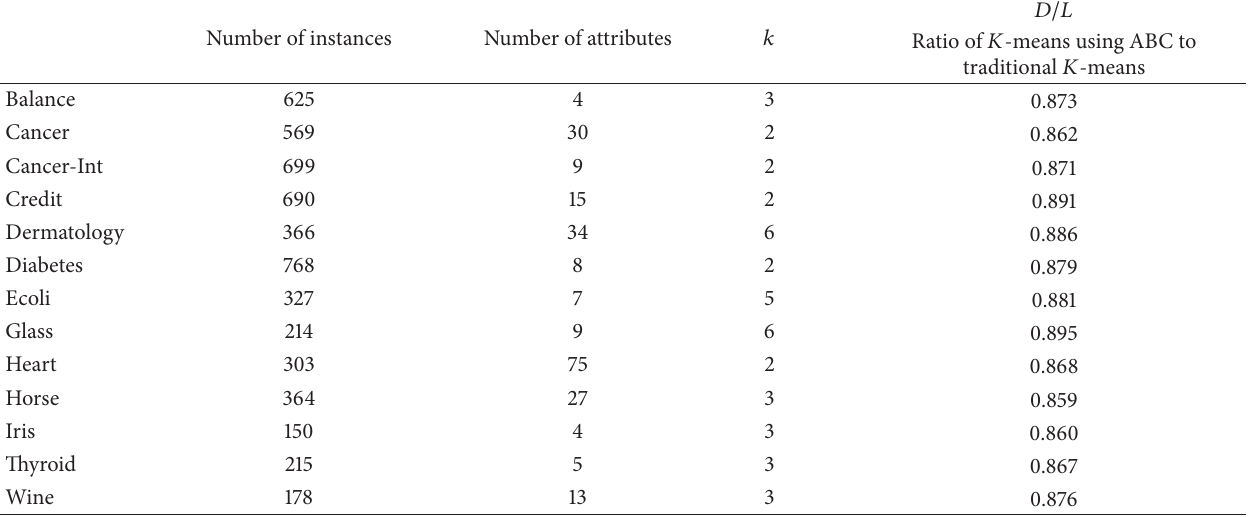
Table 1: The ratio of 𝐾 -means using ABC to traditional 𝐾 -means in metric 𝐷/𝐿